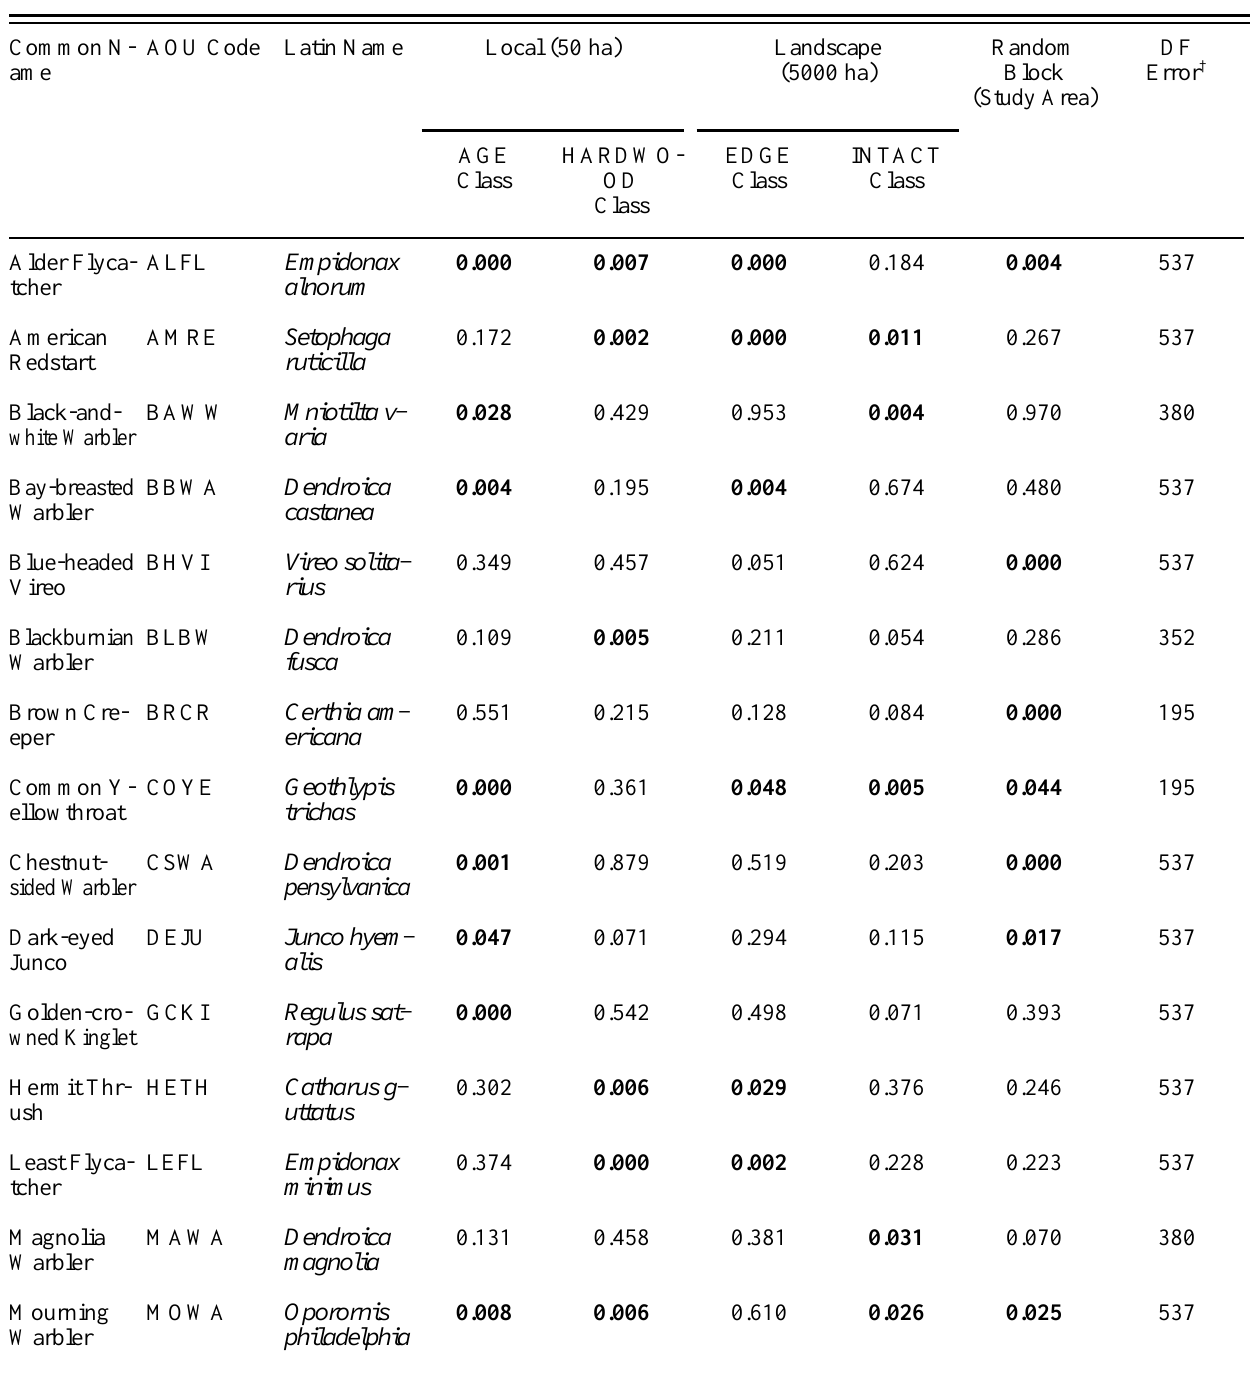
Table 4. Significance (ANOVA p values) of songbird relative abundance response to local- and landscape- level effects. Values <0.05 are set in